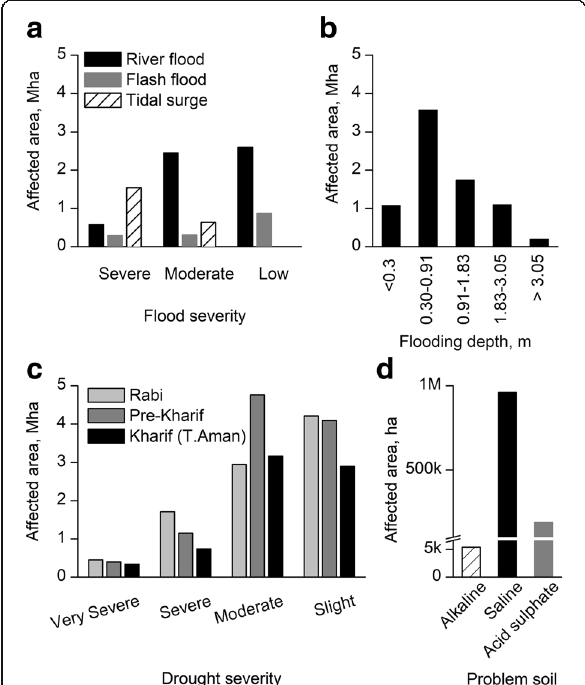
Fig. 12 Extent of the agroecological constrained areas of Bangladesh a Flood-prone areas by flooding types. Severity of flooding is classified based on the recurrence of flooding and the extent of crop damage. Severe represents occurrence of floods 5 times or more in 10 years timeframe with considerable loss/damage of standing crops, where moderate means 3-4 times occurrence with significant loss/damage while low represents occurrence at least twice in 10 years timeframe with loss of standing crops. b Flood-prone areas by flooding depth, c Drought-prone areas by crop seasons. Severity of drought is classified based on the extent of yield reduction. Very severe, severe, moderate, and slight severity represent yield reduction of more than 50%, 30-50%, 15-30% and below 15%, respectively, d Other agroecological constrained areas. (Map of the agroecologically constrained areas of Bangladesh is shown in Additional file 3: Figure S3). Information